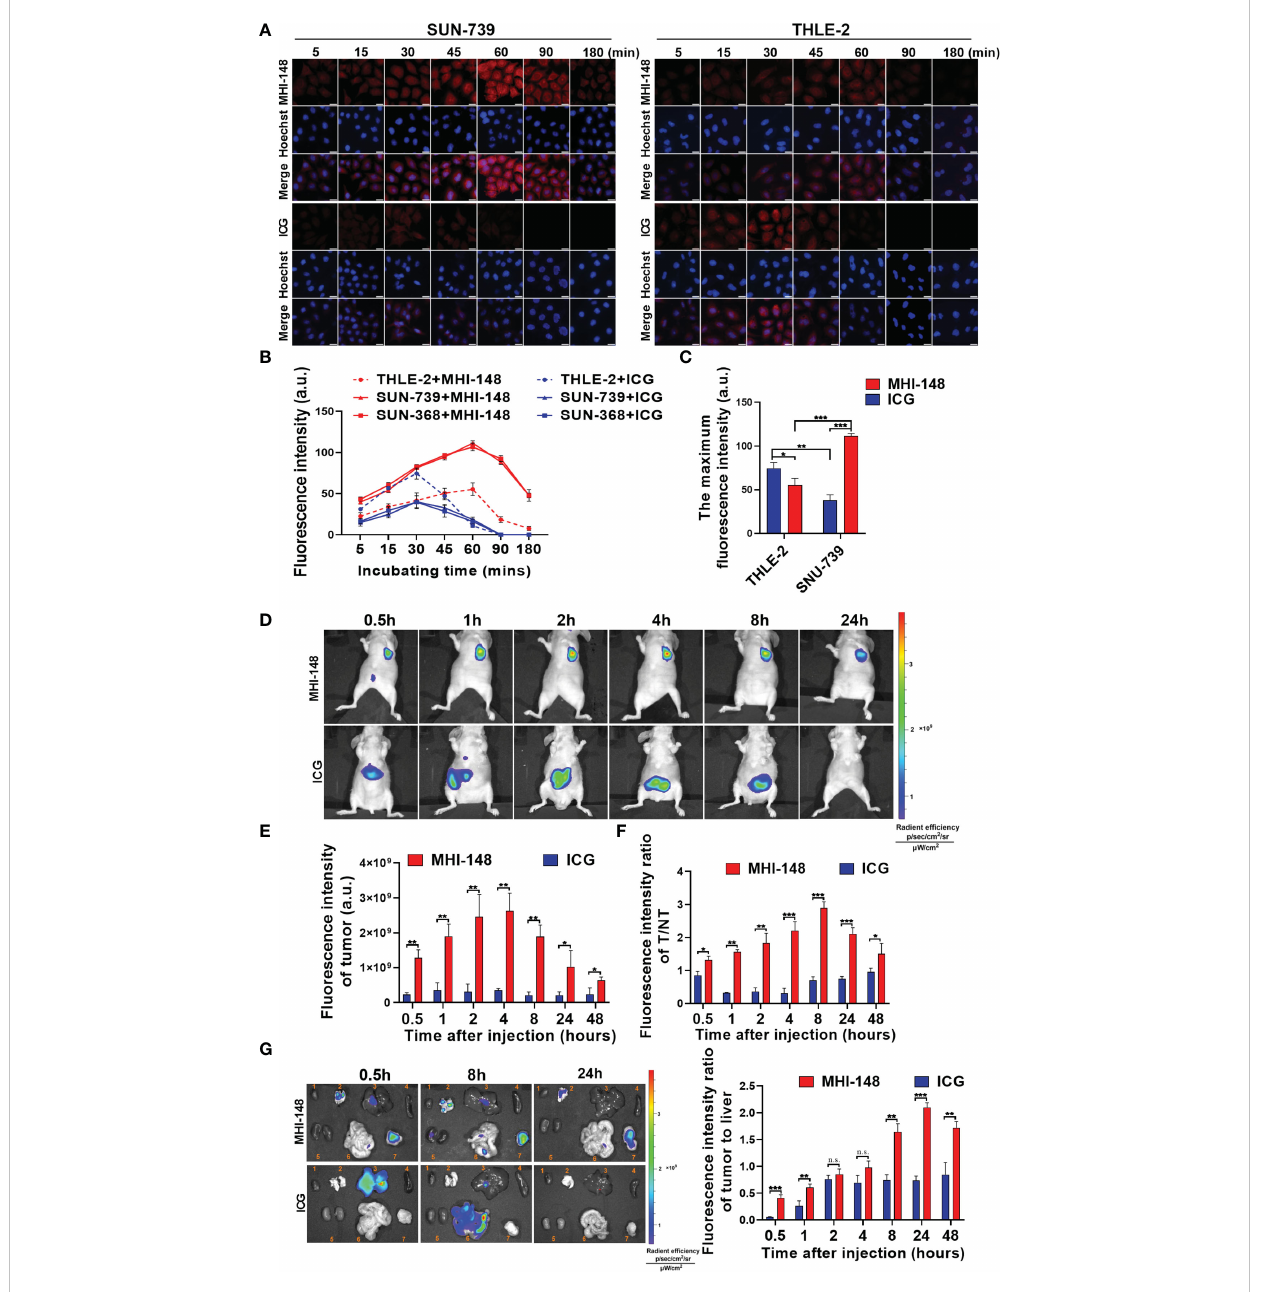
FIGURE 1 Near-infrared fl uorescence imaging of HCC cells by NIRF dyes MHI-148 and ICG in vitro and in vivo . (A) Representative images of cells staining with NIRF dyes in SNU-739 cells and THLE-2 cells. Cells were treated with 10 m M MHI-148 or ICG for different time as indicated. Scale bar, 20 m m. (B) Quanti fi cation of NIRF intensity in SNU-739, SNU-368 cells and THLE-2 cells. (C) The maximum NIRF intensity was compared in SNU-739 cells and THLE-2 cells, respectively. (D) Time-dependent NIRF intensity images of nude mice bearing subcutaneous tumors xenografts of SNU-739 cells after receiving an intravenous injection of MHI-148 or ICG. (E) Quanti fi cation of NIRF intensity in tumor. (F) Quanti fi cation of NIRF intensity ratios of tumor tissues to normal tissues against time. (G) Tumor tissues and normal tissues were dissected and subjected to ex vivo imaging at 0.5h, 8h and 24h after injection (left) and quanti fi cation of NIRF intensity ratios of tumor to liver (right). The organs numbered from 1 to 7 in the pictures are heart, lung, liver, spleen, kidney, intestine and tumor tissue. Data shown are the mean ± SD from three independent experiments, where appropriate. *P < 0.05; ** P < 0.01; *** P <